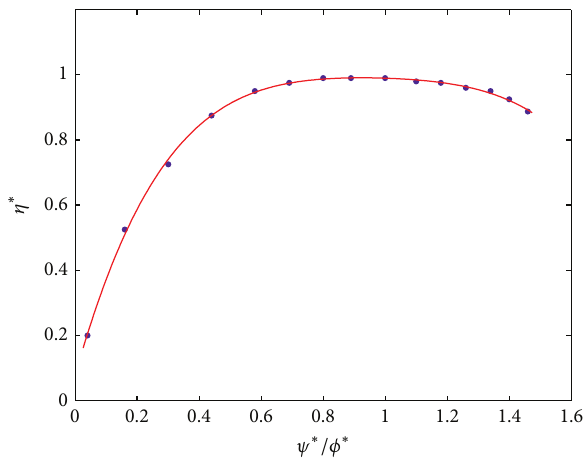
Figure 3: Generalized stage efficiency curve.